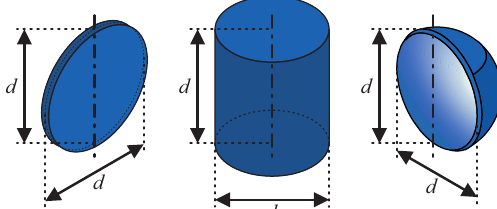
Figure 2. Target shapes (disc, cylinder and hollow hemisphere) with characteristic dimension d and rotation axes (0 ◦ for objects facing speaker/microphone with "flat" side, arbitrary for cylinder due to rotation symmetry).